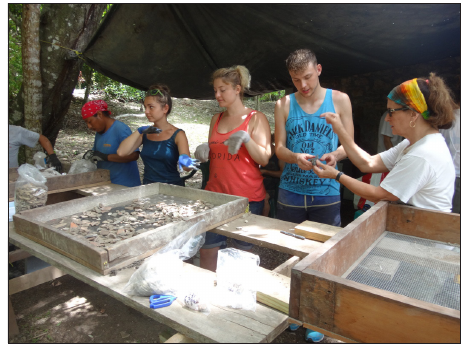
Figure 1: UCL students studying collections in Lamanai, Belize (Photo Elizabeth